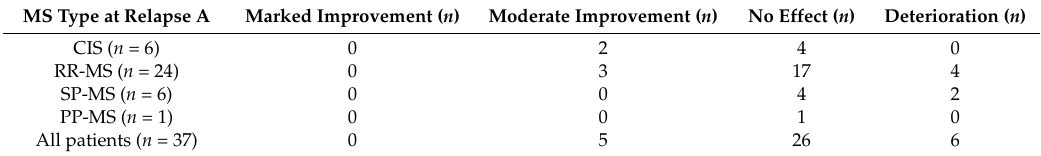
Table 2. Clinical response to GCS treatment for relapse A in patients with CIS and MS.